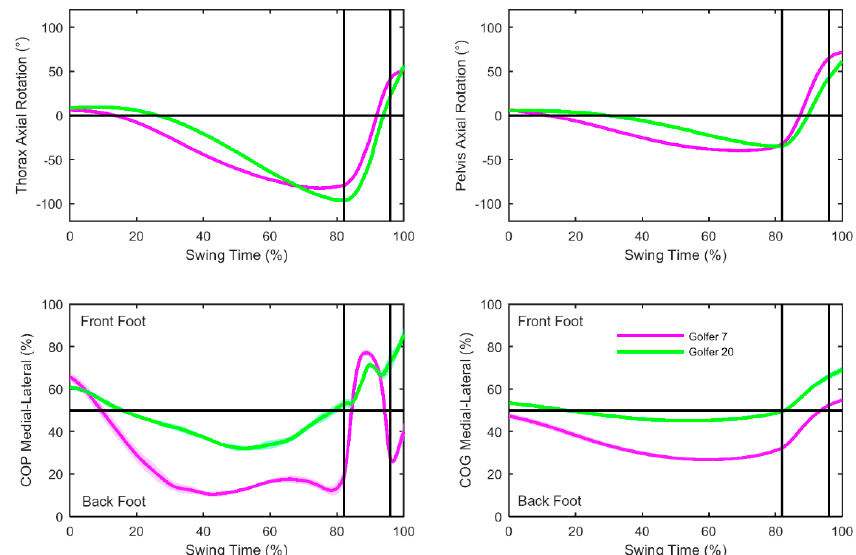
Figure 6. Examples of mean ± SD of biomechanics variables for a golfer from quadrant one (Q1) (Golfer 7, purple line, mean ± SD clubhead velocity = 49.7 ± 0.5 m·s − 1 , ball velocity = 70.7 ± 1.1 m·s − 1 ) and quadrant two (Q2) (Golfer 20, green line, mean clubhead velocity = 44.9 ± 0.3 m·s − 1 , and ball velocity = 65.9 ± 0.4 m·s − 1 ). Vertical lines represent top of backswing and impact, respectively.